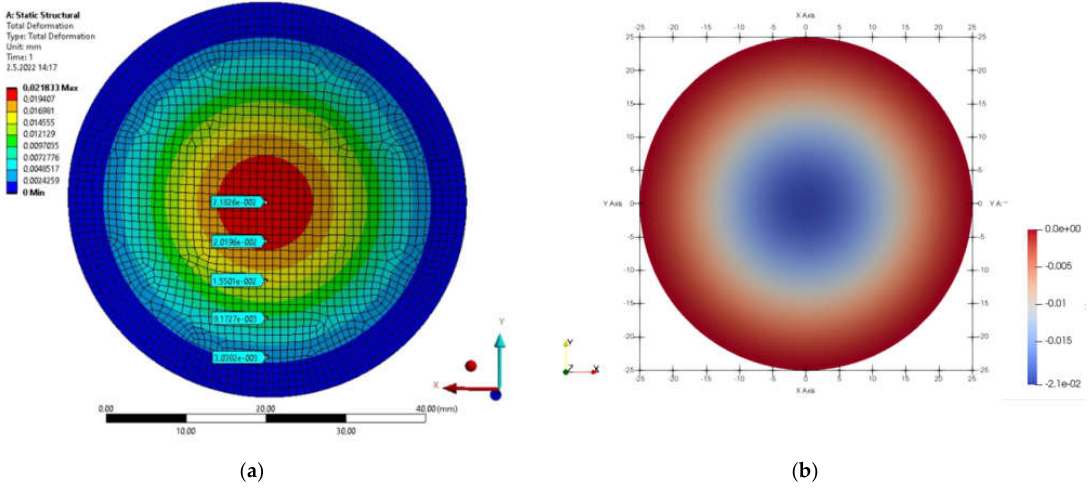
Figure 14. Total displacement field ( a ) FEM program; ( b ) MATLAB.